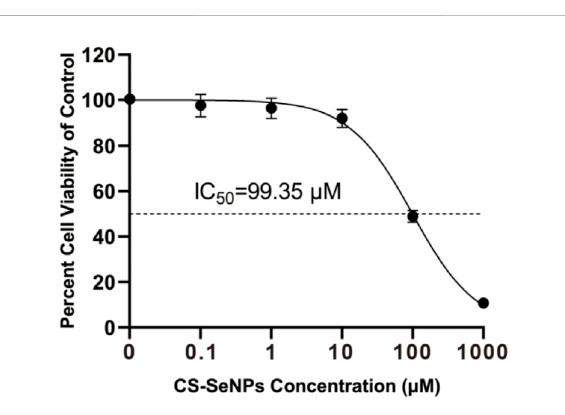
FIGURE 9 Cell viability of African green monkey kidney cell line MARC- 145 on treatment using different concentrations (0 – 1000 μ M) of chitosan – Nano-Se for 48 h by Cell Counting Kit-8 (Shao et al.,